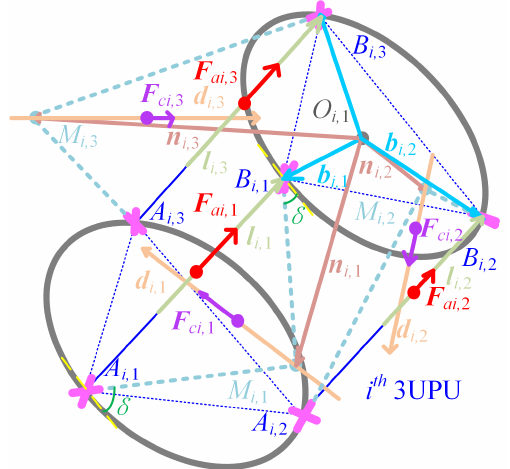
Figure 3. Schematics for the force analysis of the i th 3UPU